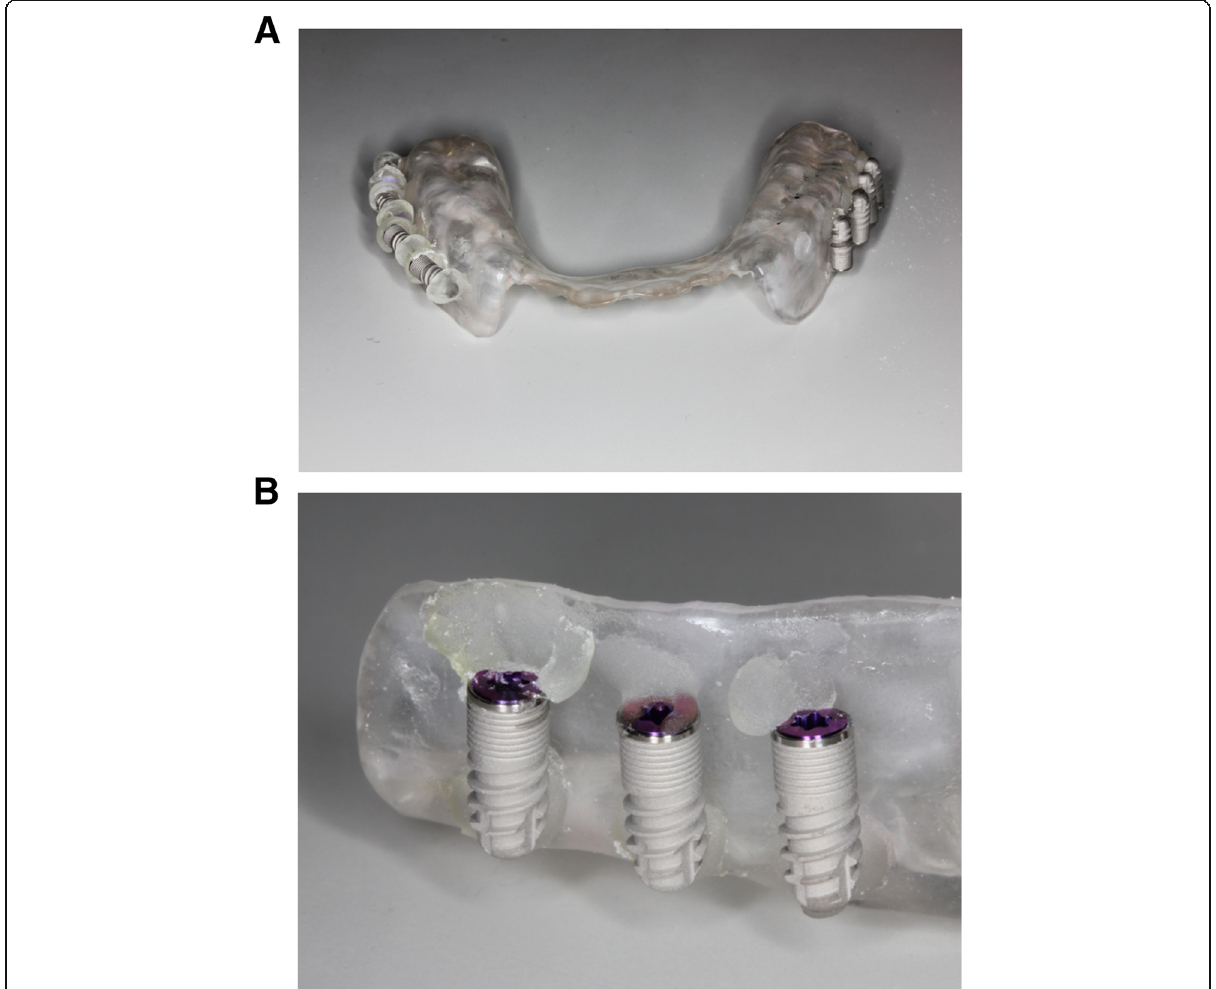
Fig. 1 Hard resin splint model carrying 6